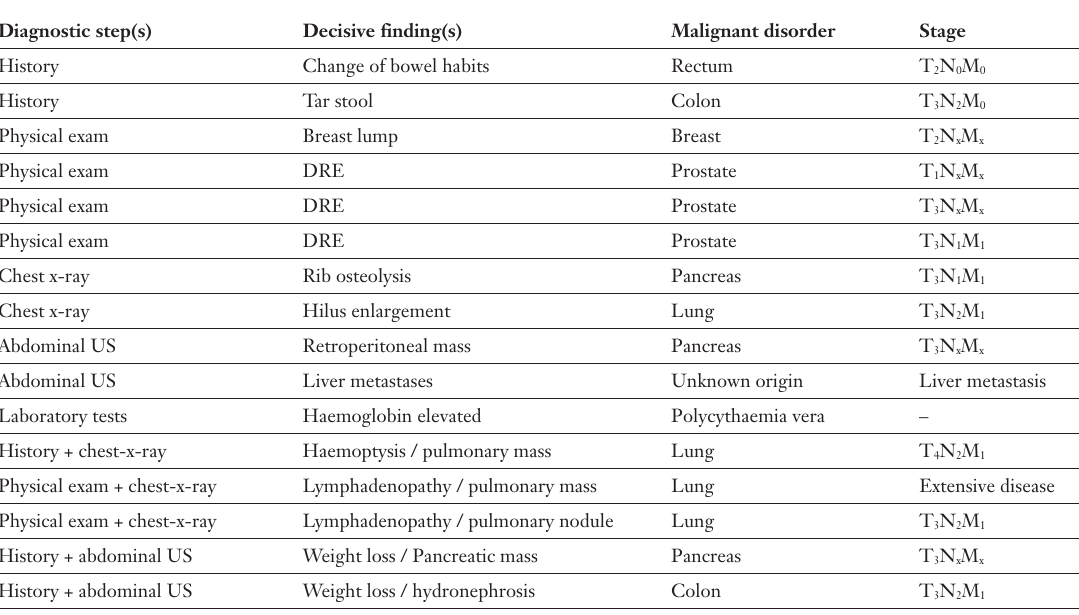
Contribution of diag- nostic steps in the evaluation of patients with deep venous thrombosis for occult